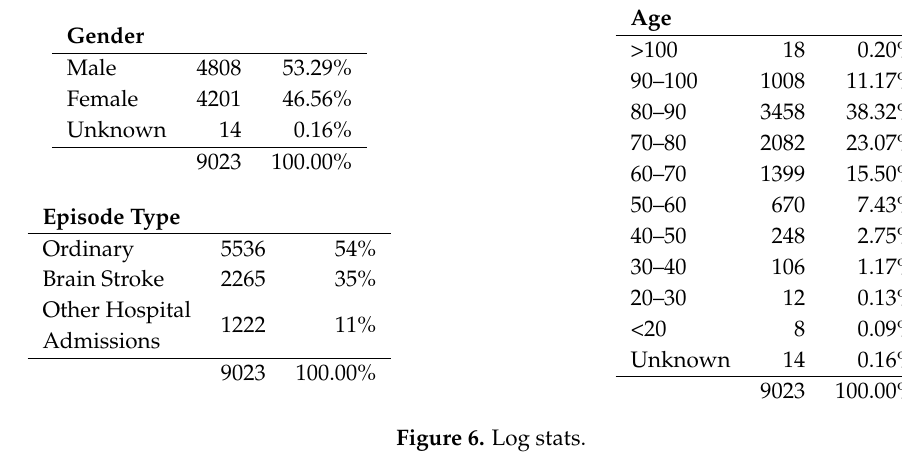
Figure 5. Log extraction from hospital computerized